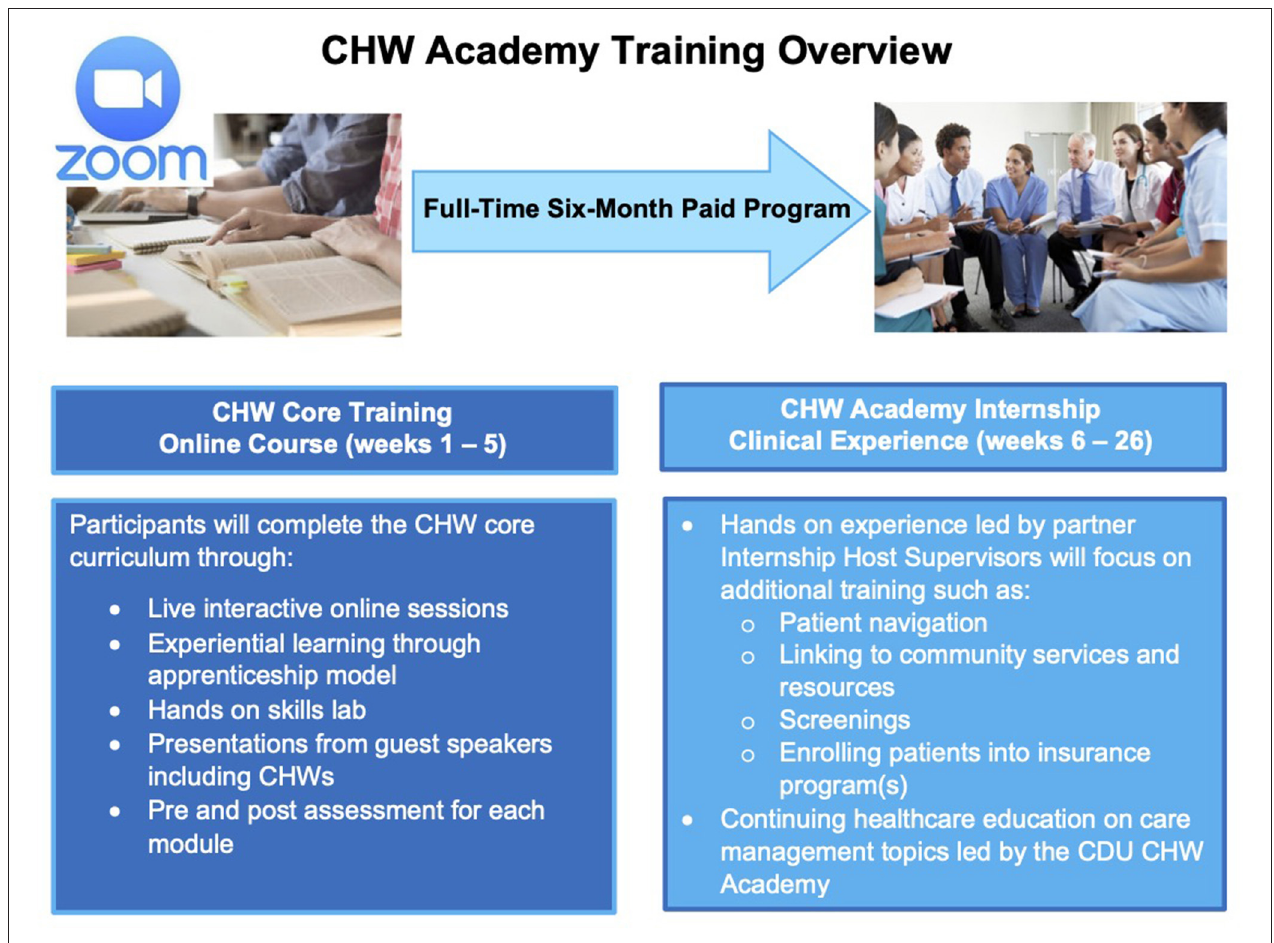
FIGURE 4 | CDU CHW academy training